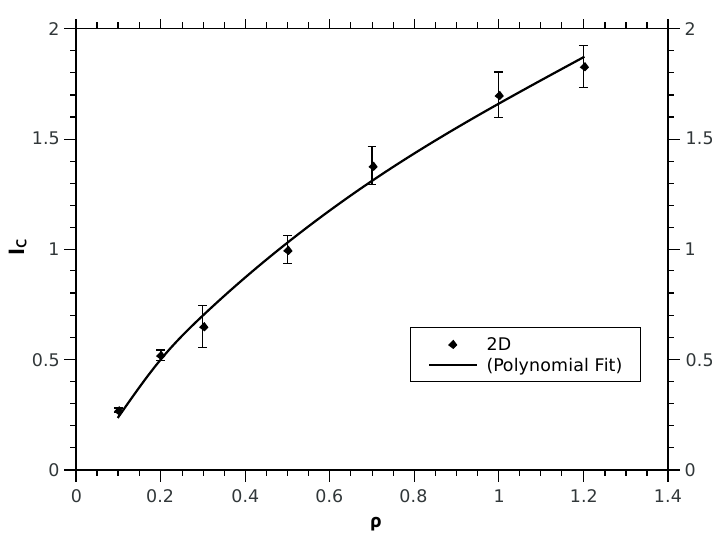
Figure 2. Computed values of I C [ ρ ( r )] for different densities in 2D obtained at optimal γ values. The Polynomial fit in this case is: I C = 0.167 ρ ( r ) + 1.851 ρ ( 1/2 ) ( r ) − 0.360 with error 0.0277. All values are in atomic units.